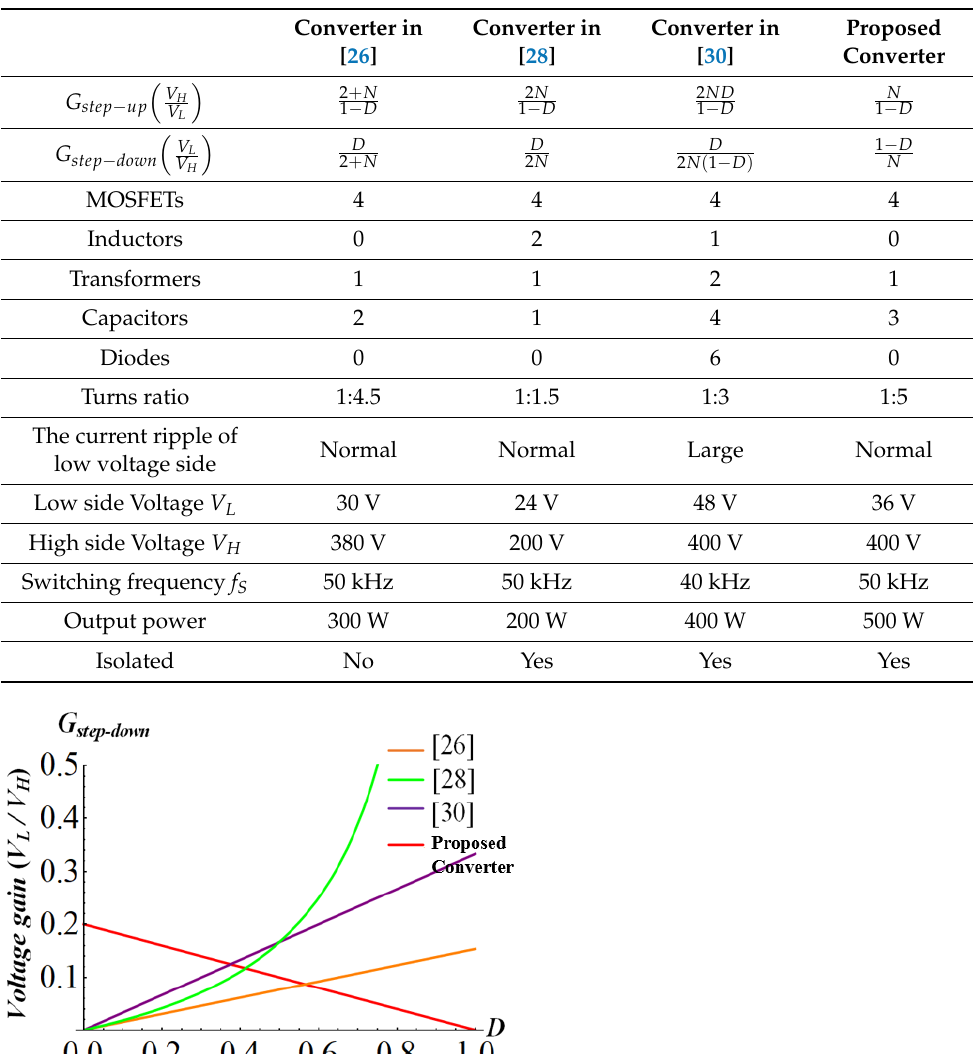
Figure 20. Comparison of voltage gains in step-down mode of the proposed converter and the con- verters in [26,28,30].